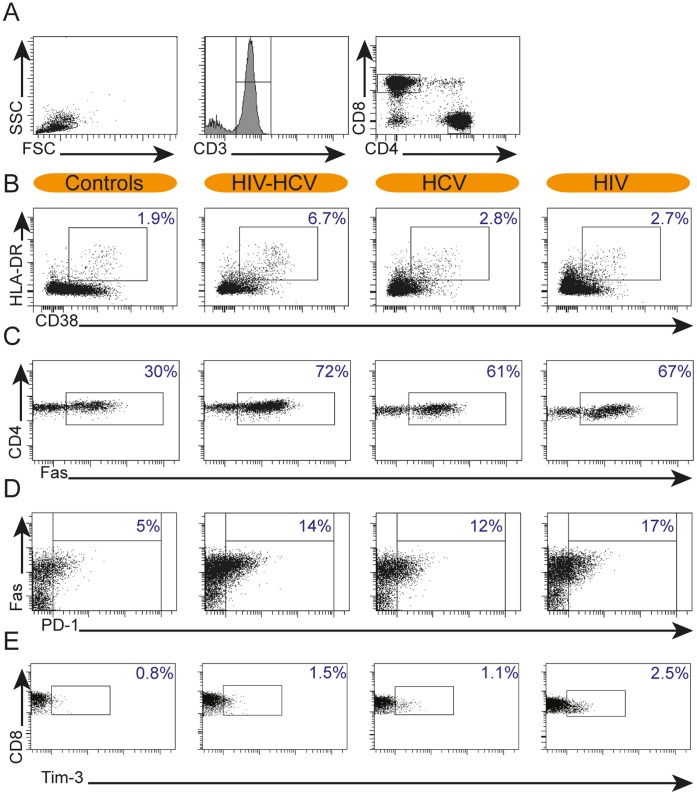
Representative flow cytometry plots.Representative flow cytometry plots of T-cell activation- and exhaustion markers in HIV-HCV coinfected patients, HCV mono- and HIV mono-infected patients and healthy controls. A: gating of CD4+ and CD8+ T-cells by lymphocyte-gate (left panel), CD3-gate (middle panel) and gates for CD4+ or CD8+ T-cells (right panel). B-E: representative flow cytometry plots of a healthy control (left), HIV-HCV coinfected (middle left), HCV monoinfected (middle right) and HIV -monoinfected patient (right) showing (B) activated CD8+ T-cells; (C) Fas-positive CD4+ T-cells; (D) PD-1 positive CD4+ T-cells and (E) Tim-3 positive CD8+ T cells. Percentages are depicted in the right upper corner.